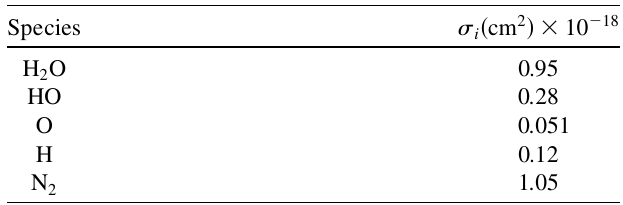
TABLE II. High-energy cross sections for electron impact